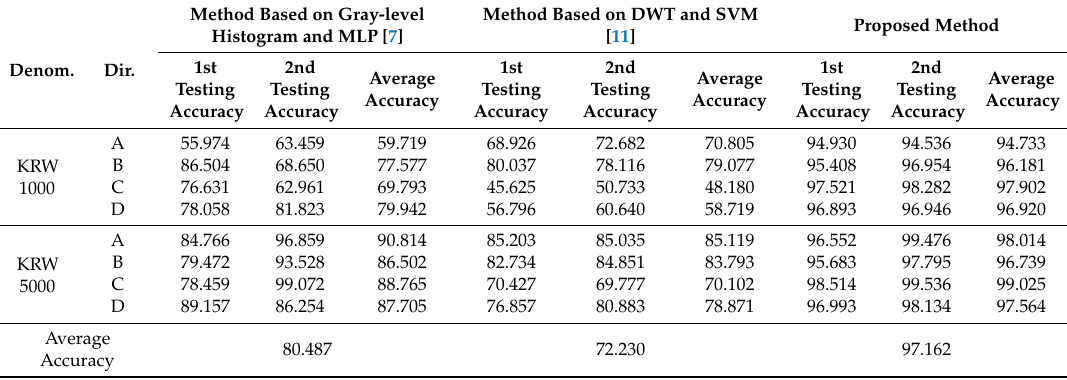
Table 7. Comparison of fitness-classification accuracy by our proposed method with that of previous studies on the KRW banknote dataset. Denom. and Dir. are denominations and directions, respectively. The 1st Testing Results and 2nd Testing Results mean the same as those in Table 4 (unit: %).